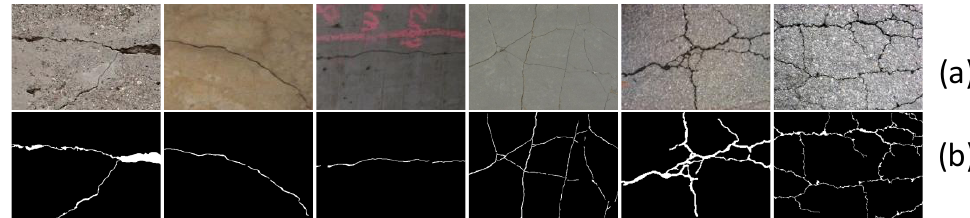
Figure 5. DeepCrack dataset: ( a ) original positive, ( b ) ground